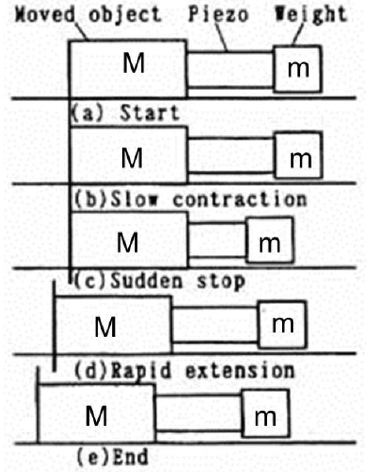
Figure 15. Operating principal of impact-drive proposed by Higuchi in 1986 [53].